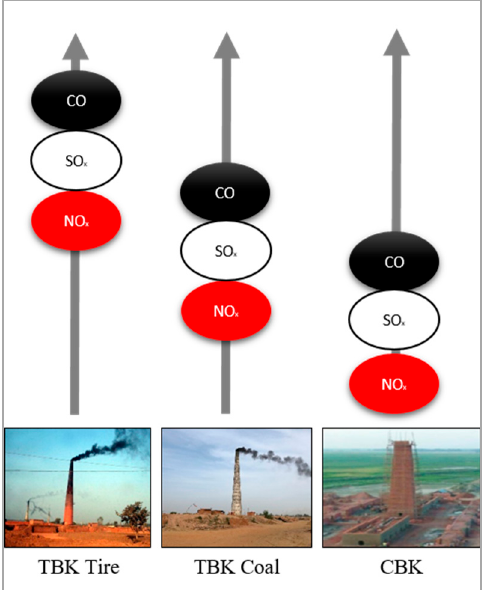
Figure 7. The comparative contribution of pollutants based on the brick kiln type, i.e., traditional brick kilns (TBK) and contemporary brick kilns (CBK).